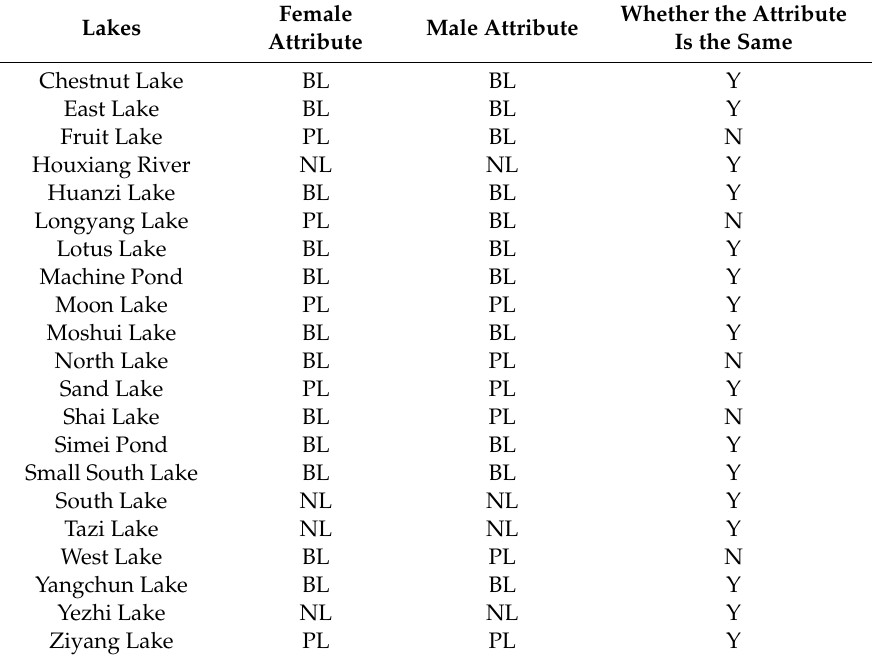
Table 5. Emotional attributes of di ff erent lakes under di ff erent